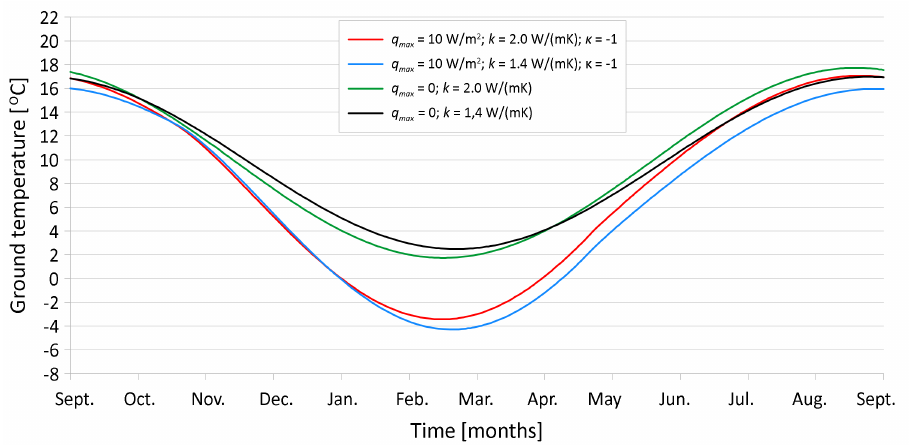
Figure 6. Influence of ground thermal conductivity on the ground temperature at the depth of heat exchanger’s installation for various conditions of heat extraction from the ground.